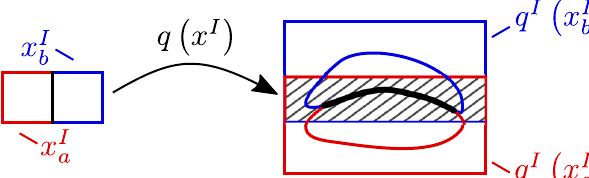
Figure 1. Overestimation of adjacent intervals in the mapping area. Common edge (illustrated in black) leads to an overlapping (illustrated as black shaded